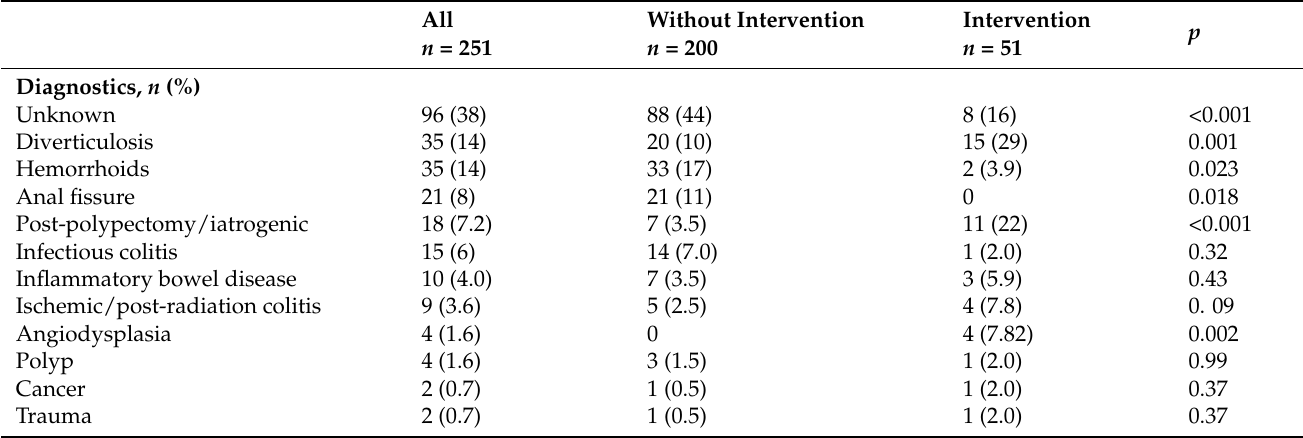
Table 4. Etiology of LGIB.